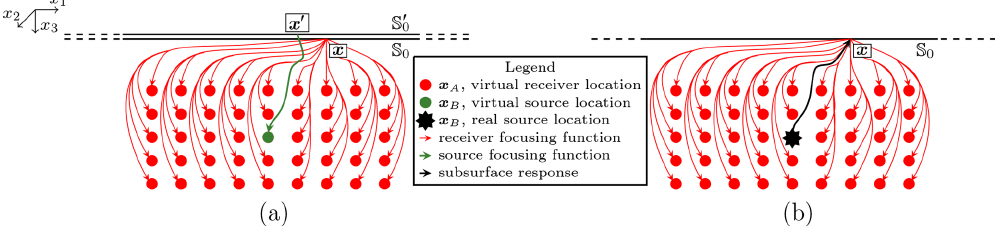
Figure 3. Schematic setup for (a) the two-step process and (b) the one-step process for retrieving the homogeneous Green’s function in the subsurface. The red and green arrows show the focusing functions that are used to respectively create the virtual receiver and virtual source location. The red and green dots show the locations for the virtual receiver and virtual source, respectively. The black star indicates the source location of a real subsurface response, indicated with a black arrow, that is measured at the surface S 0 on the same receiver location x as the focusing and Green’s functions. S (cid:48) is a surface located just above S 0 on which the source locations x (cid:48) of the reflection response p( x , x (cid:48) ,ω) 0 are located. The rays in this figure indicate full Green’s functions and focusing functions, including multiple